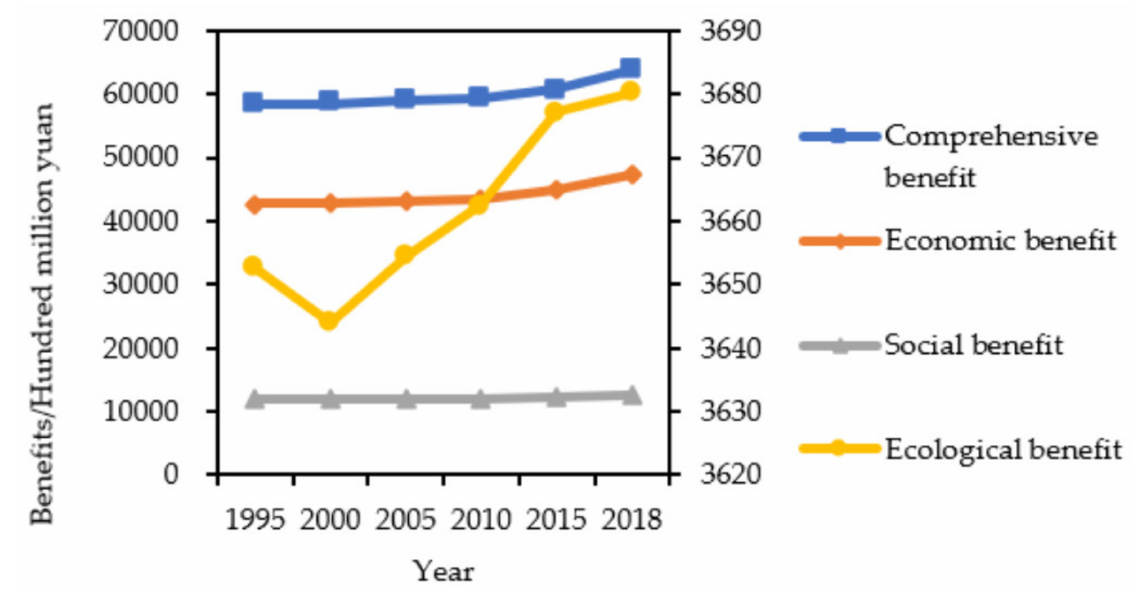
Figure 3. Land use benefits of the Yellow River Basin from 1995 to